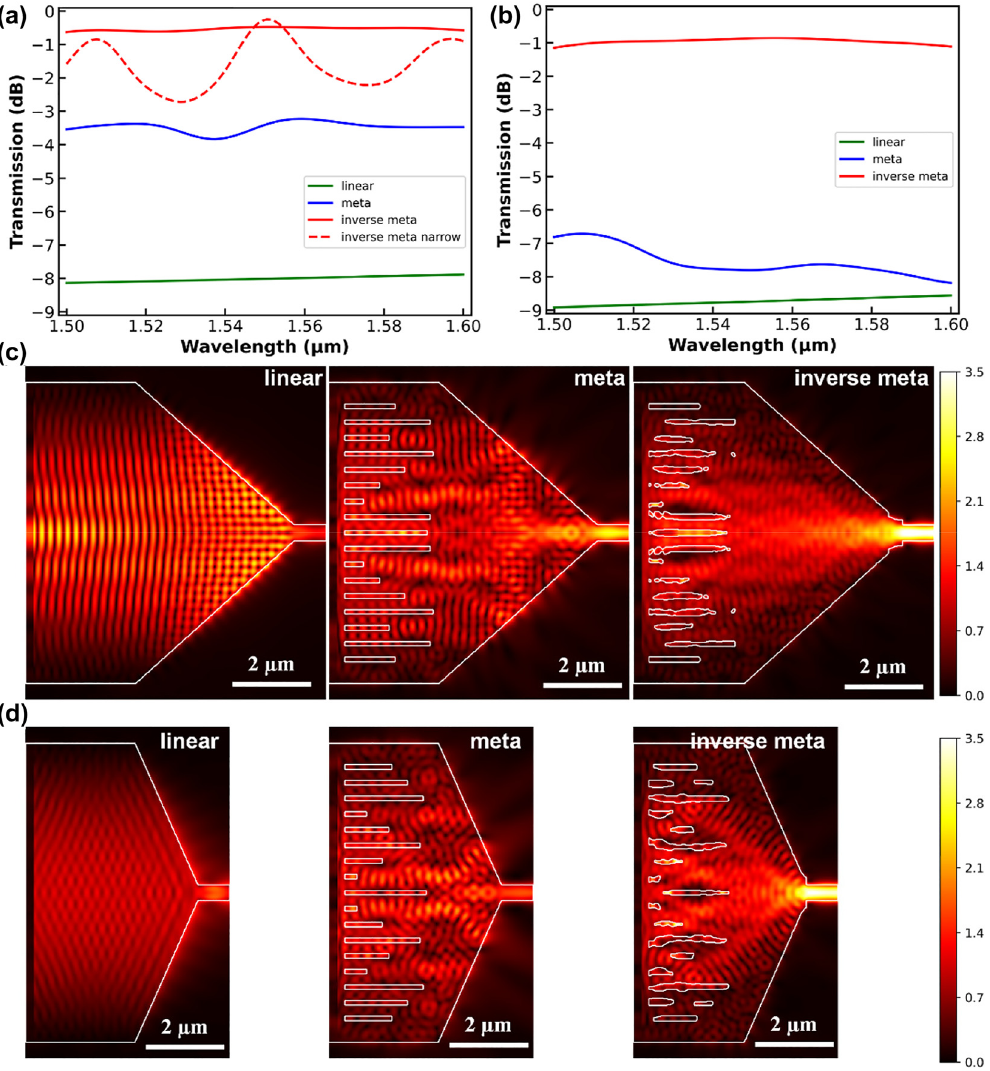
Figure 4: Simulated insertion loss of the mode-size converters with length of 8 μ m (a) and 5 μ m (b), respectively. The green lines show the simple linear taper without metamaterial structures. The red lines and blue lines plot the metamaterial mode-size converters with only manual design and after inverse design is applied. The red dashed line in (a) is the optimization results without using a broadband target function. The square of the electric field intensity ( | E | 2 ) distribution for 8 μ m device (c) and 5 μ m device